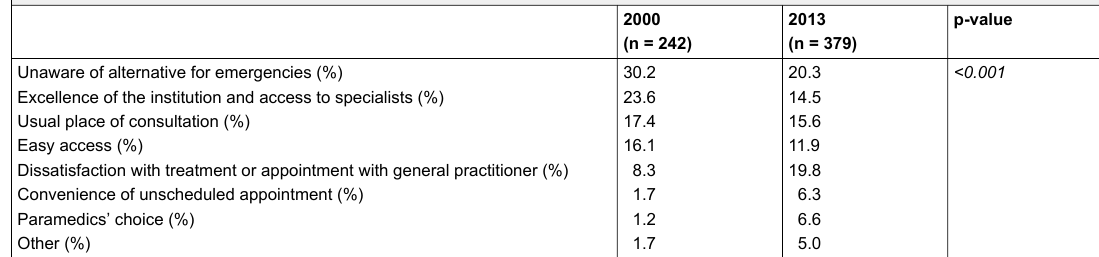
Table 3: Evolution between 2000 and 2013 of reasons for self-referral to the Emergency